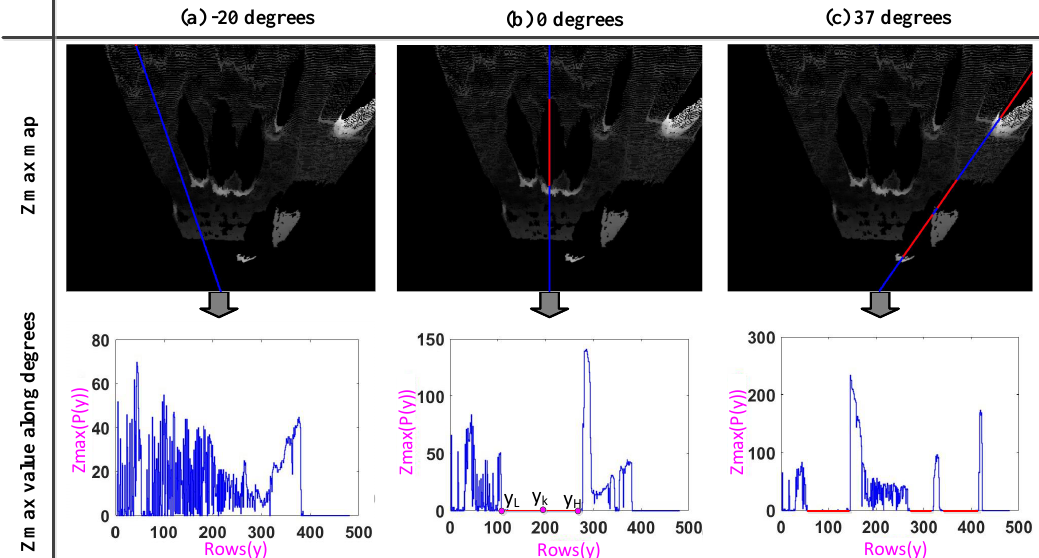
Figure 3. We select the three angles to illustrate the way of finding the shadow on the Zmax map. The blue line represents the route of looking for shadows at a camera’s viewing degrees, which is a ray. The red line indicates the shadow found at this angle. What is more, we could get the change curve of the Zmax value along this degree, and the three features of the shadow are clearly